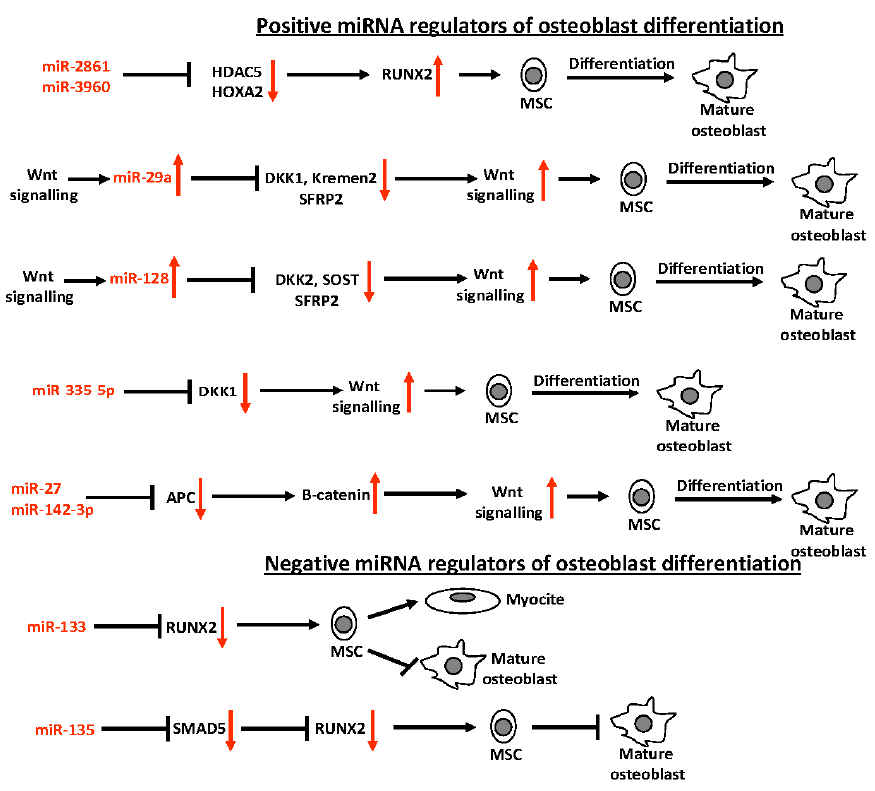
Figure 4. Schematic representation of positive ( ↑ ) and negative ( ↓ ) miRNA regulators of osteoblast differentiation.